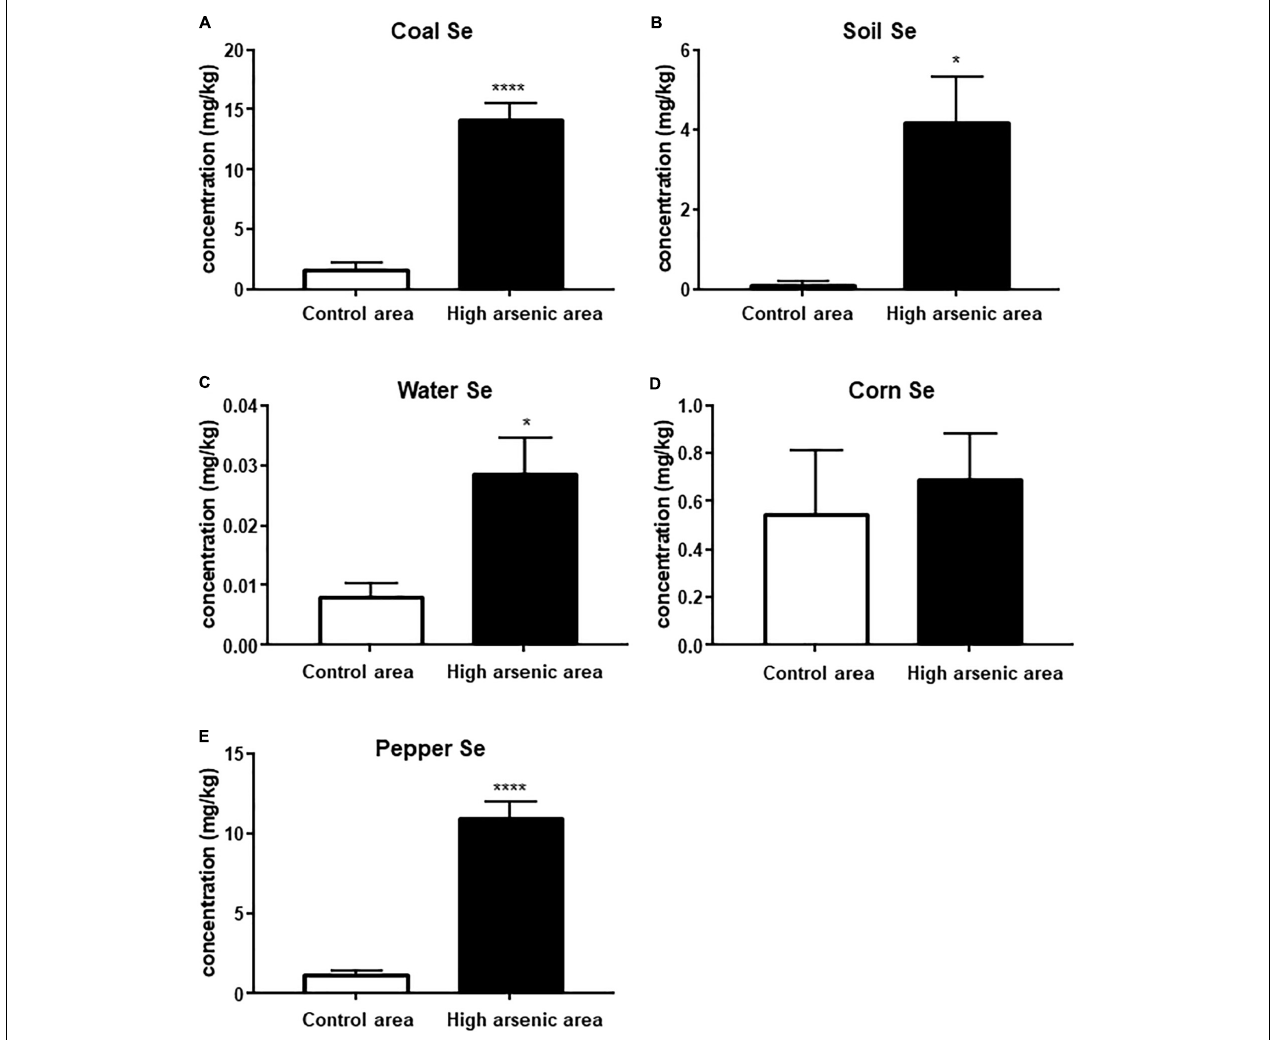
FIGURE 2 | Selenium content of coal, soil, water, corn, and pepper in Ziyang County and the control area. Data are represented by mean ± SEM. The comparison was performed by t -test. *, **** p < 0.05 and 0.0001,